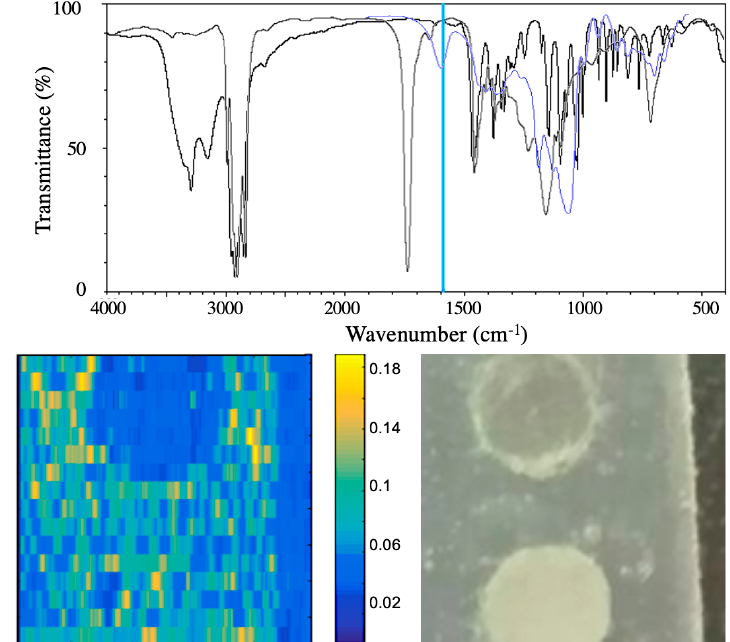
Figure 10. Top : transmittance infrared spectra of agarose (black), Intralipid ® (grey) and potato starch (blue). Bottom : images of potato starch ( upper ) and Intralipid ® (lower) pills in agarose matrix. Left panel shows the OF image taken at 6.2 µ m by raster scanning the MIR-QCL beam. Right panel shows a photo of the sample (adapted from [41]).